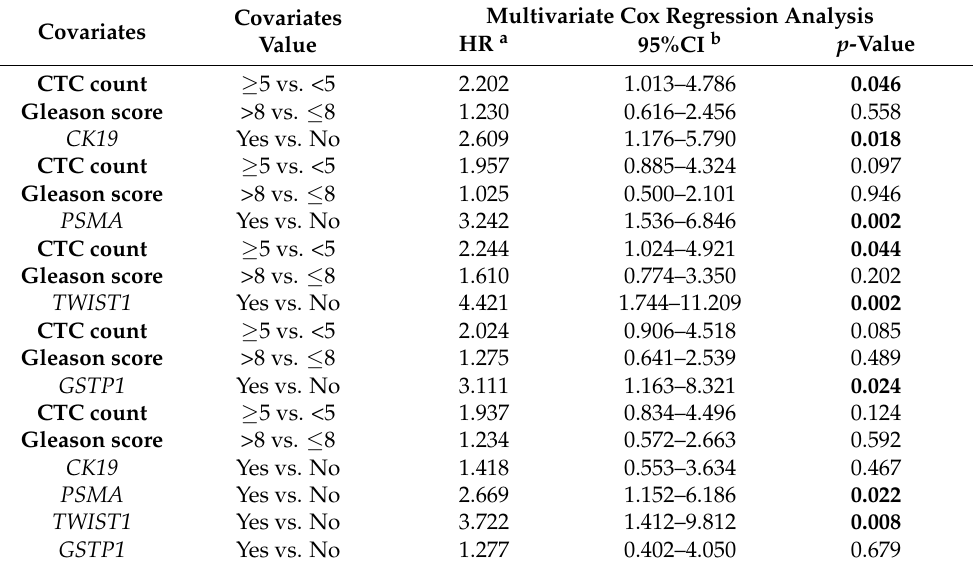
Table 1. Multivariate analyses for OS of mCRPC patients ( n =